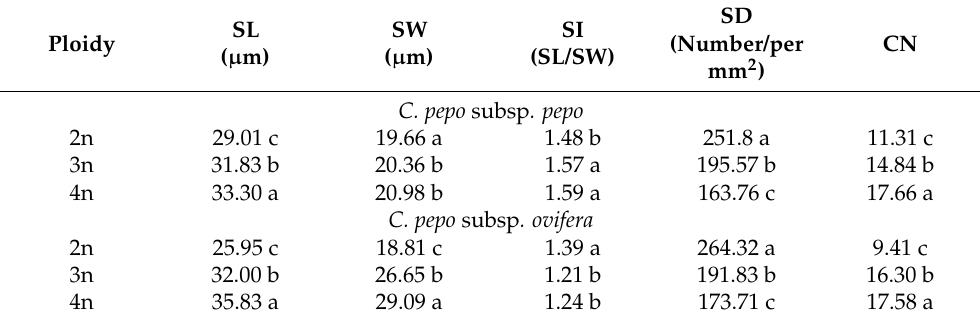
Table 2. Indices of abaxial epidermis in courgette ( C. pepo subsp. pepo ) and patisson ( C. pepo subsp. ovifera ) regenerant plants obtained in unpollinated ovule culture in vitro depending on ploidy level. SL SW SI Ploidy ( µ m) ( µ m) (SL/SW)